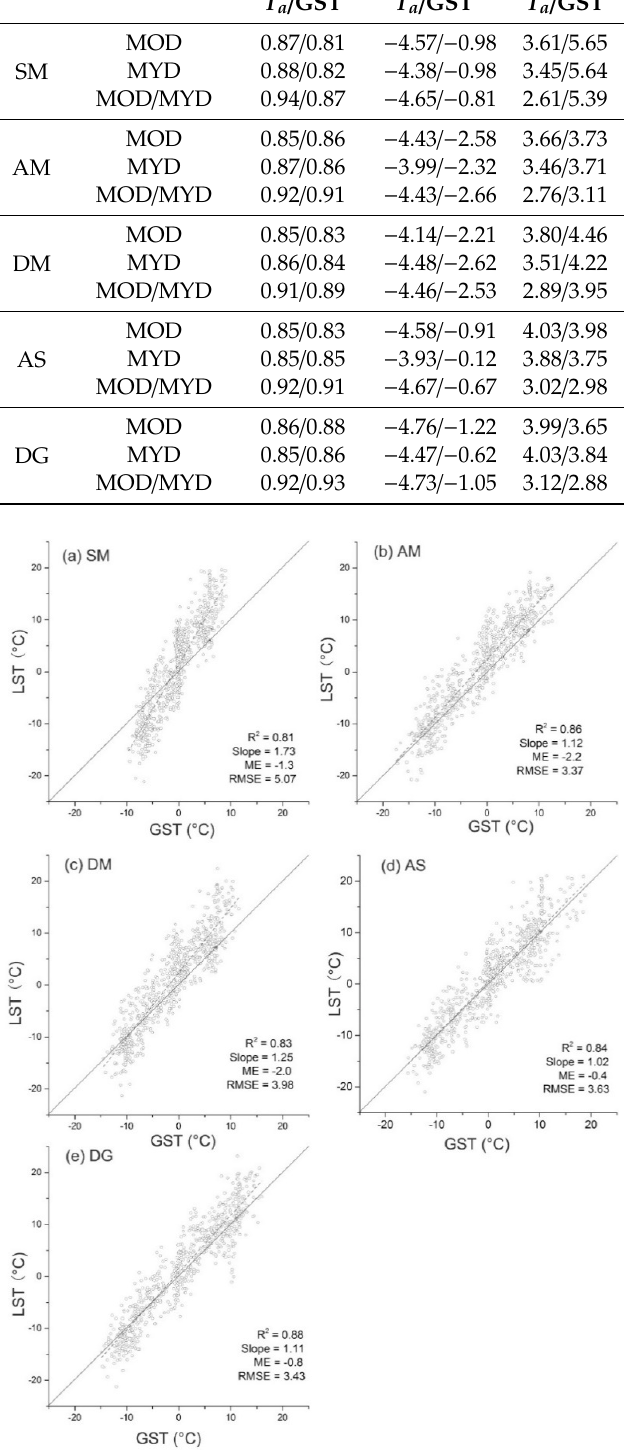
Figure 2. Comparison of daily LSTs with mean daily GST at site SM, AM, DM, AS, and DG during period of 15 August 2014–14 August 2016 (732 days). ME = mean errors.